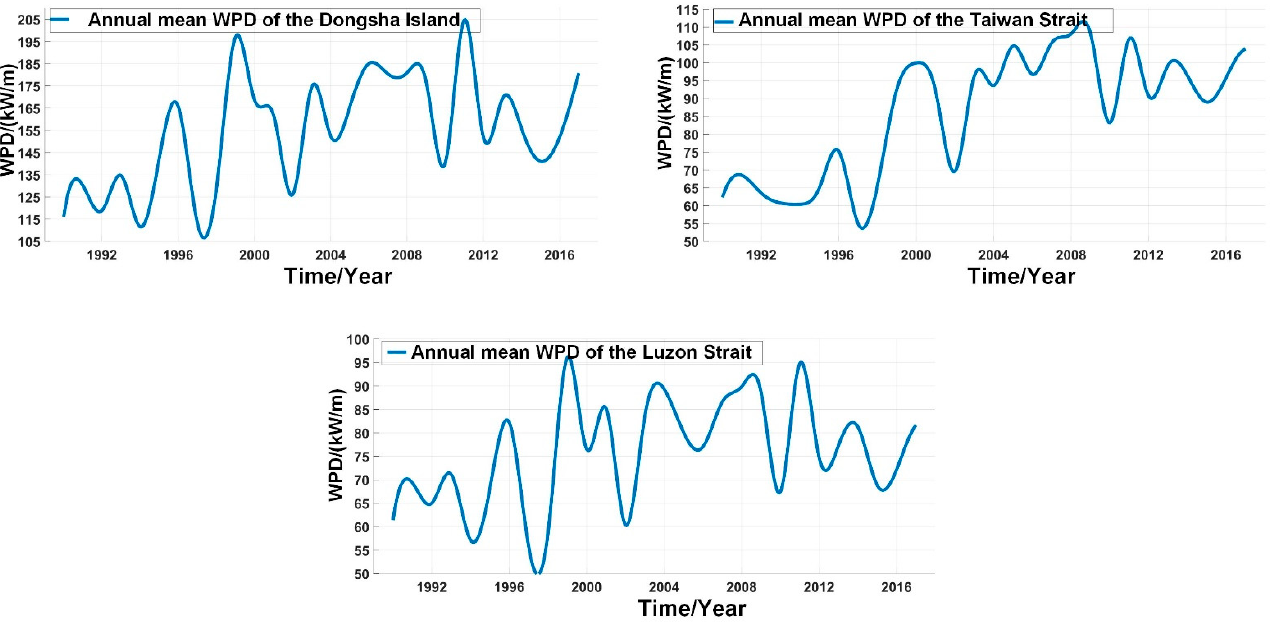
Figure 9. Variation trend of WPD in dominant sea area year by year.